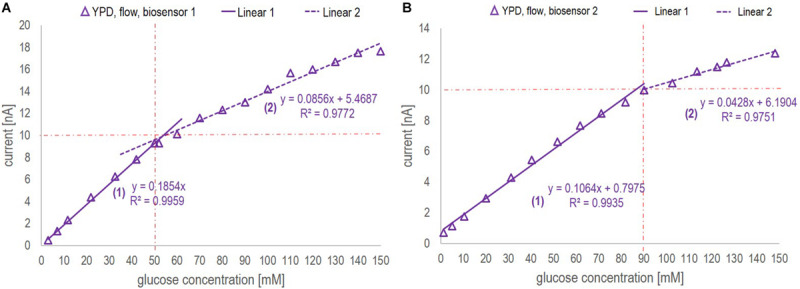
Calibration curves ranging from 1 to 150 mM glucose concentration obtained in YP medium applying a flow rate of 0.2 ml/min for biosensor chip 1
(A) and biosensor chip 2
(B). The red dotted lines indicate the division points between the low (1) and high (2) glucose concentration range. The decision, which section of the curve to apply was based on the current value. For both calibration curves, the critical current corresponds to 10 nA.